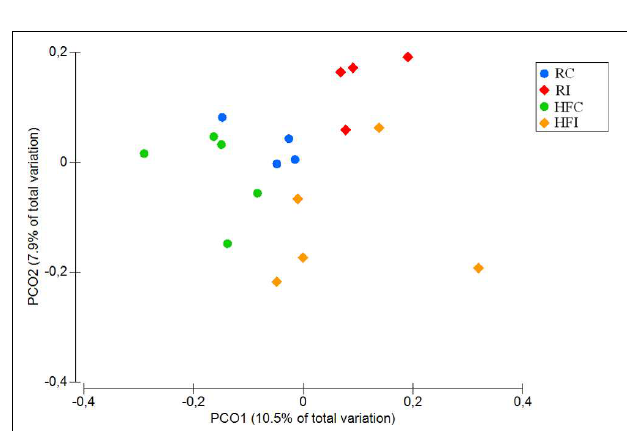
FIGURE 3 | Cecal content principal coordinates analysis (PCoA) of unweighted UniFrac distances. Significant p -value = 0.01 for Infected vs. non-infected comparison was obtained from